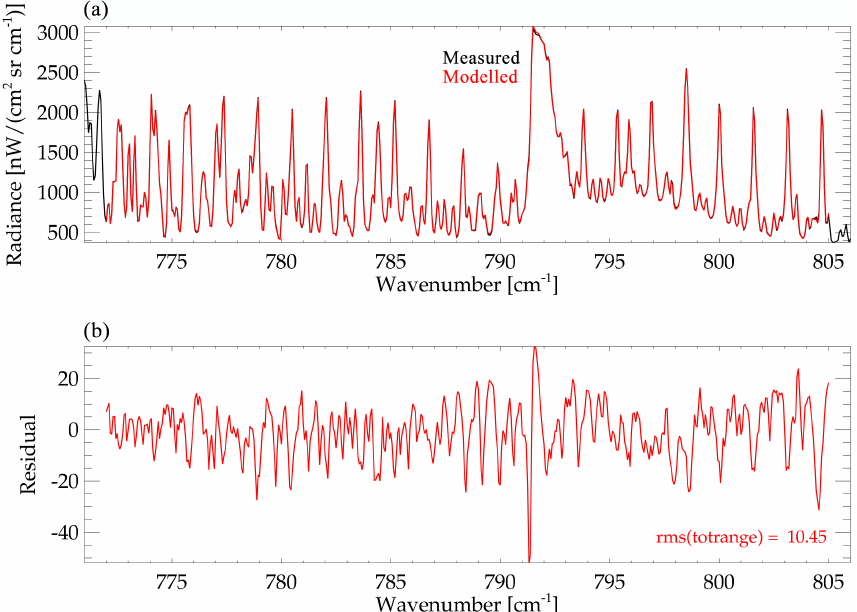
Figure 5. Impact of the CO 2 Q-branch at 11.5km altitude taking line mixing it into account: (a) spectra; (b) residuals. Black: measured spectrum, hardly discernible because overplotted by modelled spectra. Note the different scale of the residual axis compared to Fig.